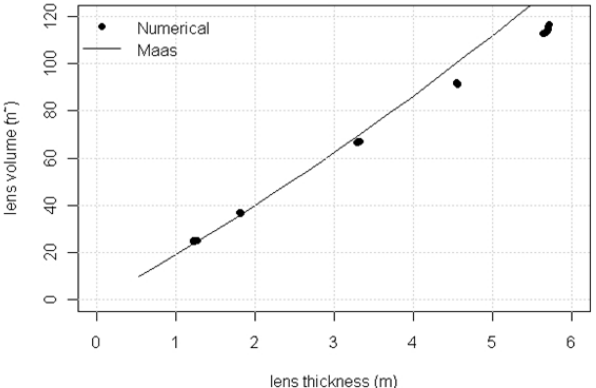
and V n f P s s